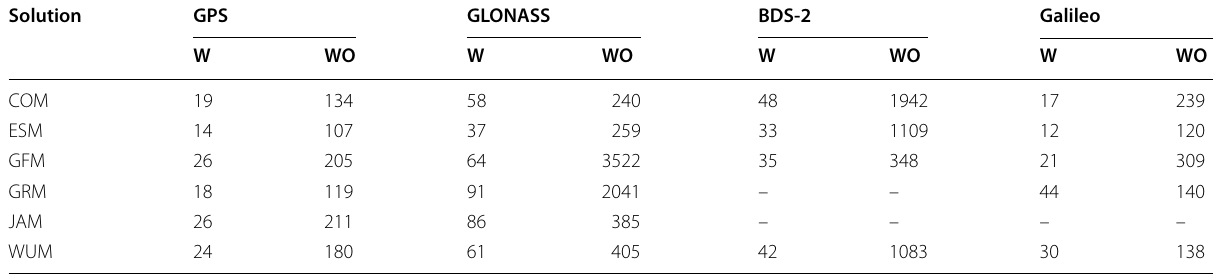
Table 2 RMS of AC clock for different constellations compared to combination with (W) and without (WO) ASB correction. The GEO satellites are excluded from the BDS-2 solution statistics (unit: ps) Solution GPS